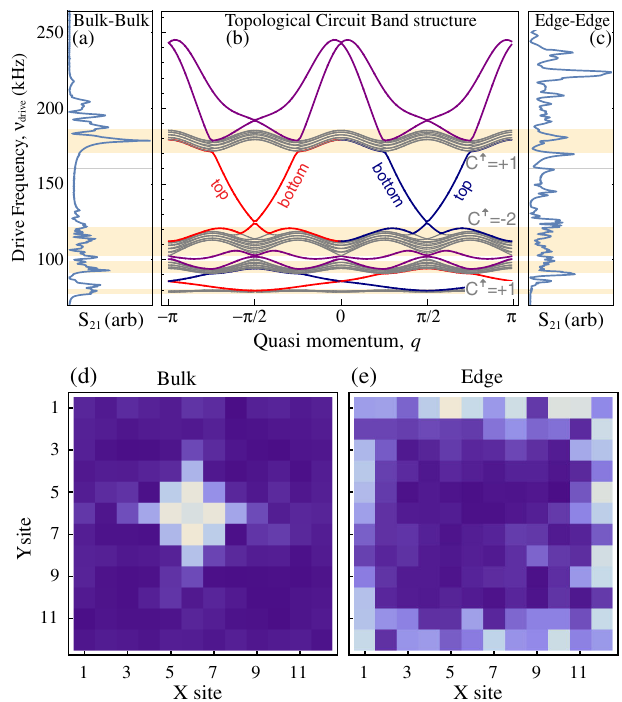
FIG. 2. Site-resolved measurement of band structure and density of states (DOS). (a) The experimentally observed coupling (linear scale) between two points in the bulk of the circuit TI (blue line) with the bulk states indicated (orange bands). (b) Band structure of a circuit TI. A strip of circuit TI with fixed boundary conditions in the transverse direction is numerically diagonalized at finite longitudinal quasimomentum q , yielding four massive bulk bands (gray), and spin-orbit-locked edge states (red ¼ ↑ , blue ¼ ↓ ) that reside in the bulk gap. The labels “ top ” and “ bottom ” denote the boundary that each edge mode prop- agates along (with opposing group velocities d ω =dk ). The spin- Chern numbers ( C ↑ ) of the spin-up bands are indicated next to each band ( C ↓ ¼ − C ↑ ). The additional edge modes (indicated in purple) are not topologically protected. The higher-energy protected edge channel is localized to a single site along one direction, while the lower energy protected edge-channel is localized to two sites, respectively. (c) Experimentally observed coupling between two sites on the edge of the circuit, showing transmission through edge modes even within the bulk gaps. The structure within the gaps is to be expected, as the system is finite so the edge exhibits Fabry-Pérot resonances. (d) Experimental site-resolved response to excitation at a central lattice site, within the band gap at 160 kHz, showing bulk localization. (e) Exper- imentally observed, site-resolved edge-mode structure at 160 kHz. The arrows in (a) and (c) reflect the frequency of excitation in (b) and